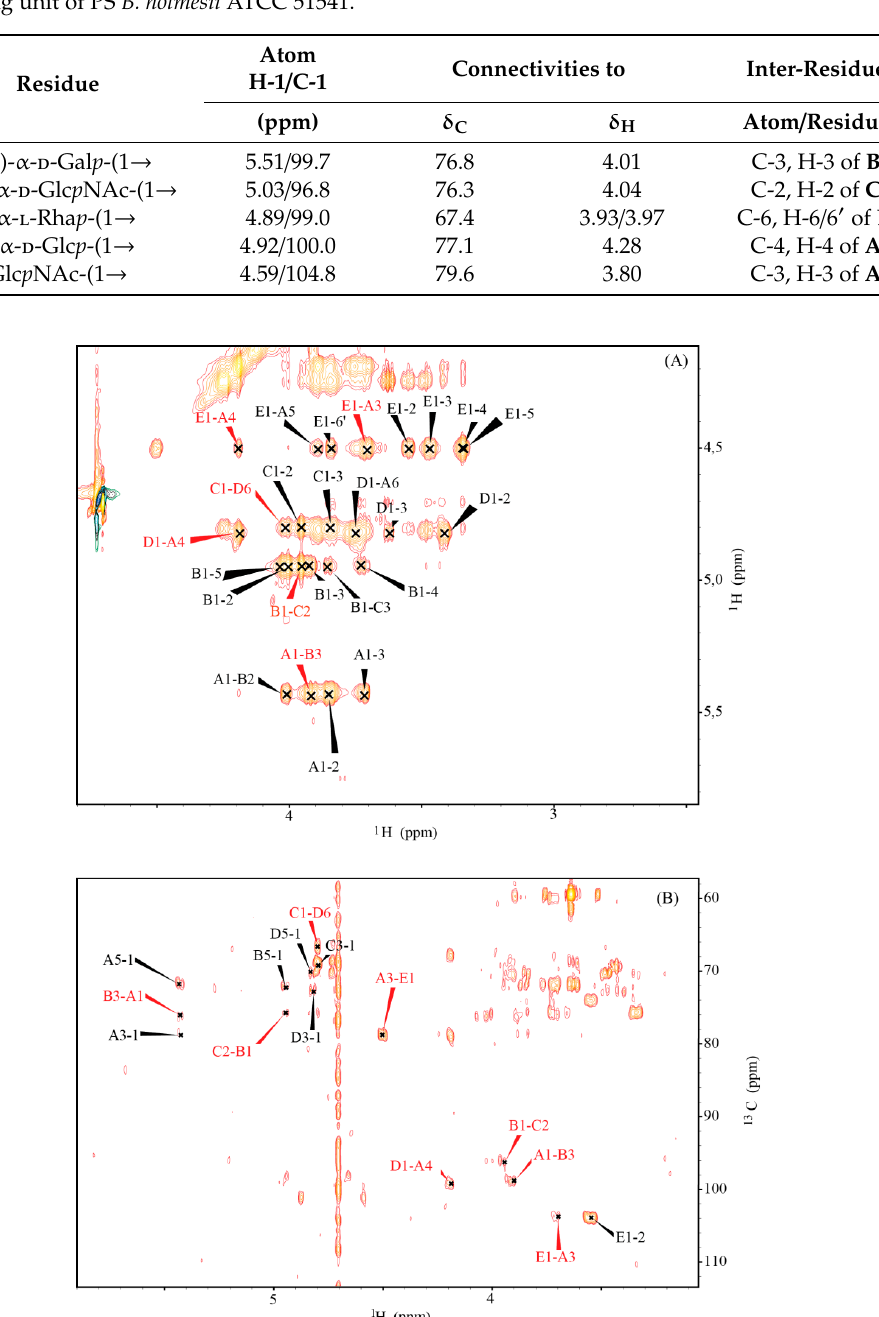
Table 2. Selected inter-residue NOE and 3 J H , C -connectivities from the anomeric atoms of the O- antigen repeating unit of PS B. holmesii ATCC 51541.